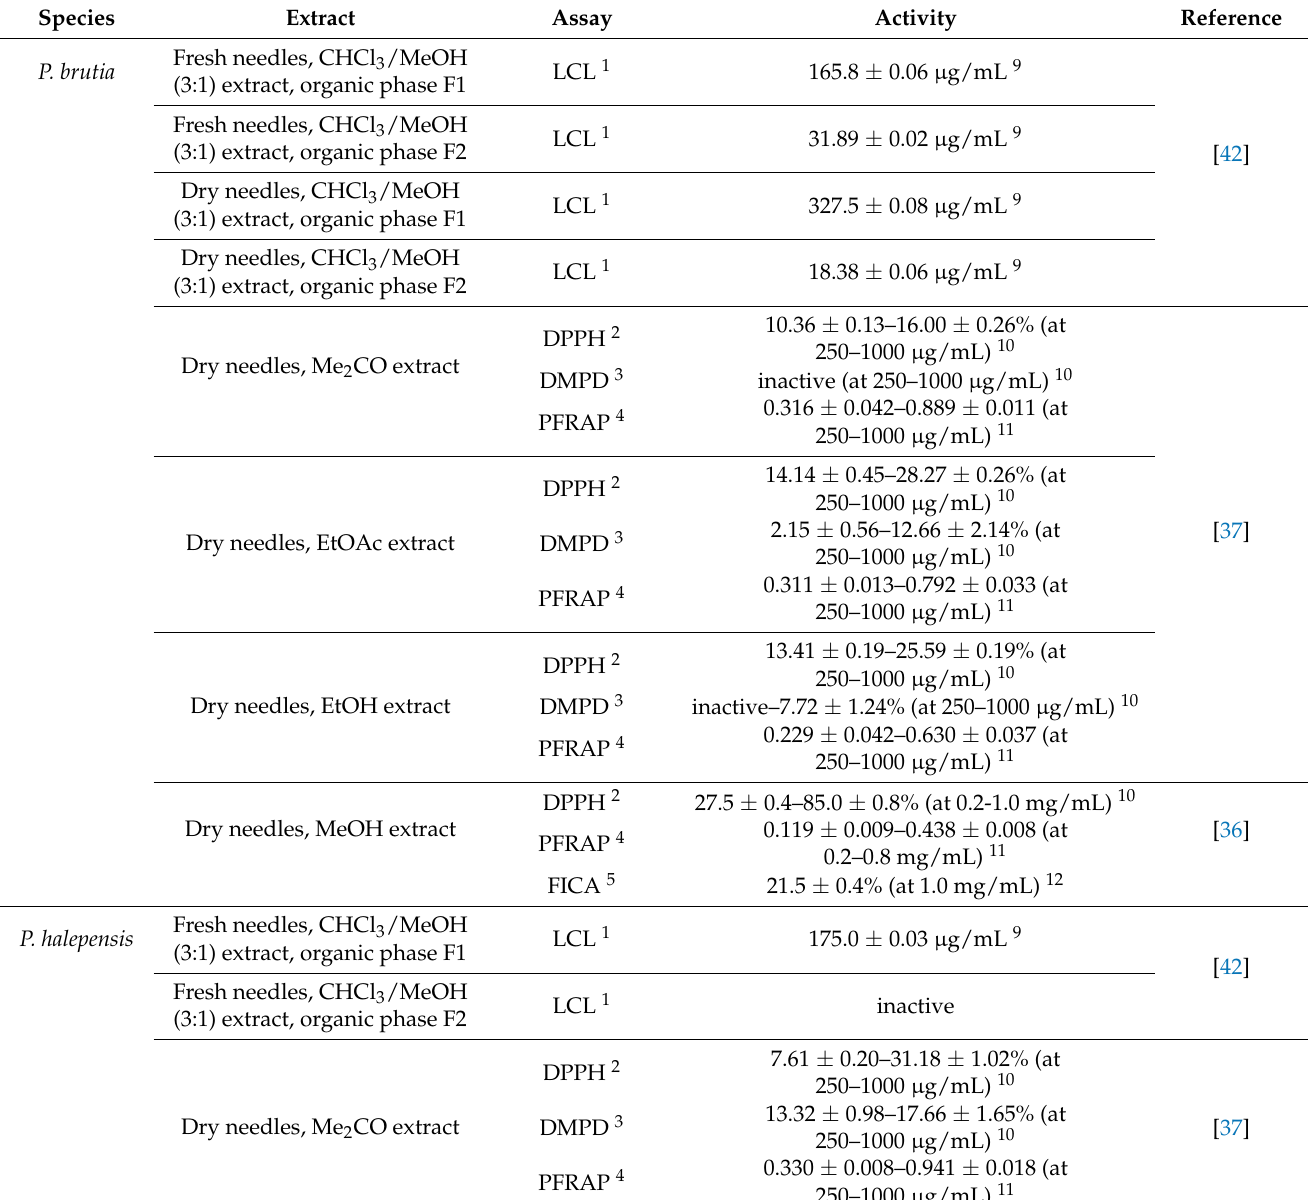
Table 2. Antioxidant activity of various needle extracts of Pinus taxa previously reported in the literature.